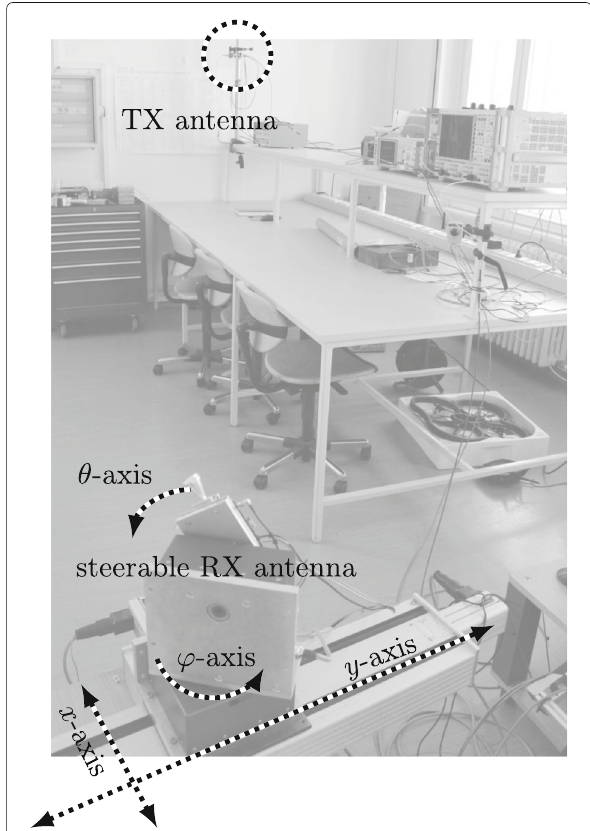
Fig. 4 Photograph of the mechanical set-up for MC1 from the receiver point of view. The receive antenna, a conical 20dBi horn, is mounted on a multi-axis positioning and rotating system. The azimuthal and elevation angle are controlled to scan the whole upper hemisphere. The multi-axis system moves and rotates the horn antenna such that its phase centre stays at the same ( x , y ) coordinate during the directional